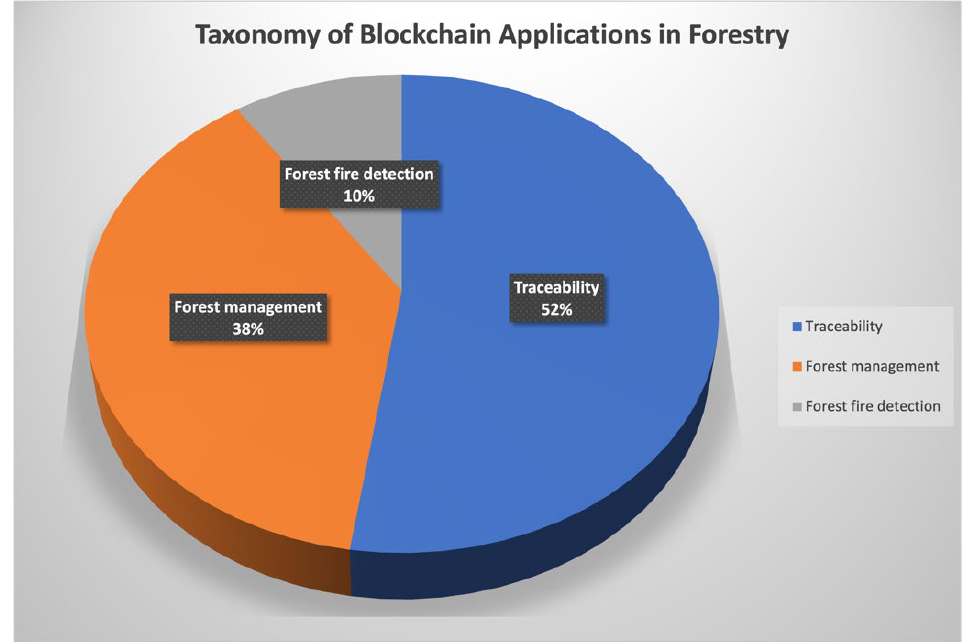
Figure 5. Taxonomy of blockchain applications in forestry.